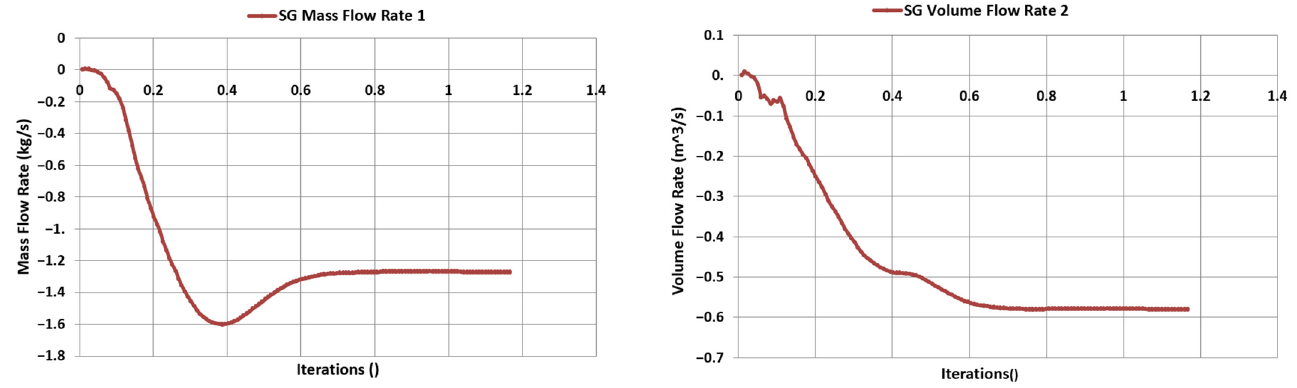
Figure 16. Mass and volume flow rate of turbine intake for Figure 11. Table 4. Numerical results of mass and volume flow rate for the compressor outflow (Figure 11).